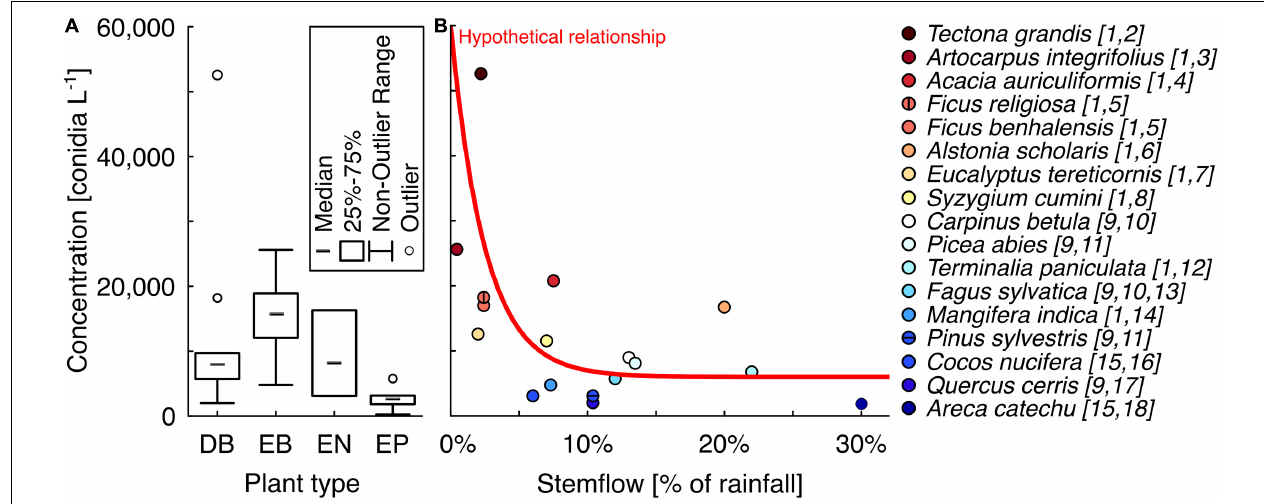
FIGURE 3 | (A) Box and whisker plot comparing the stemflow conidia concentrations measured from different plant types studied to-date: DB, deciduous broadleaved; EB, evergreen broadleaved; EN, evergreen needleleaved; and EP, evergreen palms. (B) Plot of available data on stemflow conidia concentration and the mean stemflow (fraction of rainfall). Note that (i) for many species with observations of conidia concentrations (in panel A ) the authors were unable to find published observations of stemflow fraction and (ii) these datasets (conidia concentration and mean stemflow fraction) were collected using different sampling methods (see methods discussion). However, a relationship between these variables, similar to what has been observed for solute concentrations in past work, may be hypothesized. All data for these plots were from publications: [1] Sridhar and Karamchand (2009), [2] Tanaka et al. (2017), [3] Mali et al. (2020), [4] Bruijnzeel et al. (1987), [5] Ficus benjamina from Guevara-Escobar et al. (2007), [6] Ray (1970), [7] Nizinski et al. (2011), [8] Sahu et al. (2006), [9] Gönczöl and Révay (2006), [10] Mitscherlich (1981), [11] Cape et al. (1991), [12] Ndakara (2012), [13] Peck (2004), [14] Ndakara (2016), [15] Ghate and Sridhar [2015c], [16] Serrano (1982), [17] Mosello et al. (2002), and [18] Cheng et al.